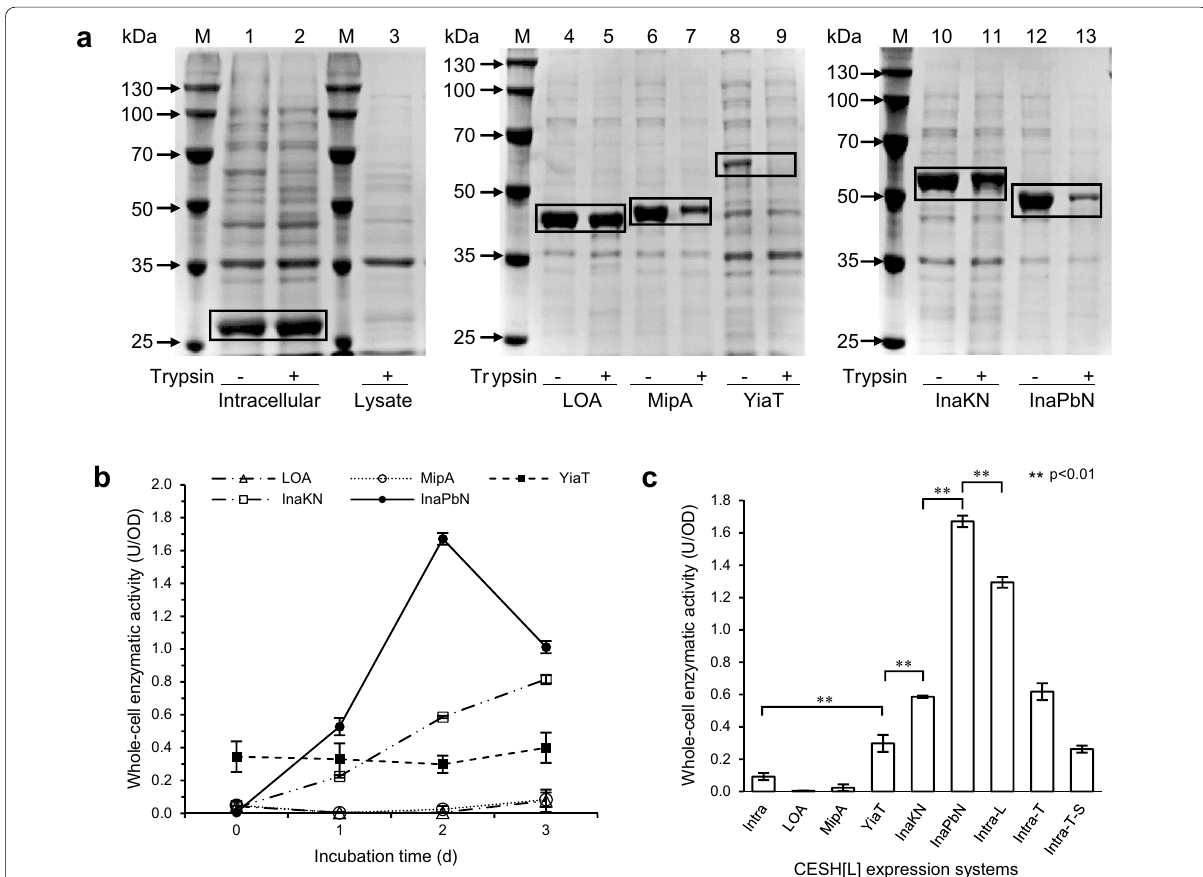
Fig. 1 CESH[L] surface display efficiencies of different anchoring motifs. a SDS-PAGE analysis of the whole cells or the cell lysate with and without trypsin treatment. Lanes 1–2, whole cells of intracellular CESH[L] expression system without and with trypsin treatment; Lane 3, trypsin-treated cell lysate of the intracellular CESH[L] expression system. Lanes 4–13, each pair of lanes are trypsin-untreated and treated whole cells expressing LOA-CESH[L], MipAV 140 -CESH[L], YiaTR 232 -CESH[L], InaKN-CESH[L], and InaPbN-CESH[L], respectively. Lanes M, standard protein molecular weight markers. b Whole-cell activities of various CESH[L] expression systems incubated at 4 °C for different days. c Comparison of the surface display systems and intracellular expression system. Intra, LOA, MipA, YiaT, InaKN, and InaPbN represent the cells expressing intracellular CESH[L], LOA-CESH[L], MipAV 140 -CESH[L], YiaTR 232 -CESH[L], InaKN-CESH[L], and InaPbN-CESH[L], respectively. Intra-L, Intra-T, and Intra-T-S represent the whole-cell lysate, the Triton X-100 treated cells, and the supernatant after the Triton X-100 treatment, respectively, of the intracellular expression system. The activities of all surface display systems were measured after 2-day incubation at 4 °C, while the activities of the intracellular expression system were measured without incubation. Symbols ** indicate significant differences with p-values less than